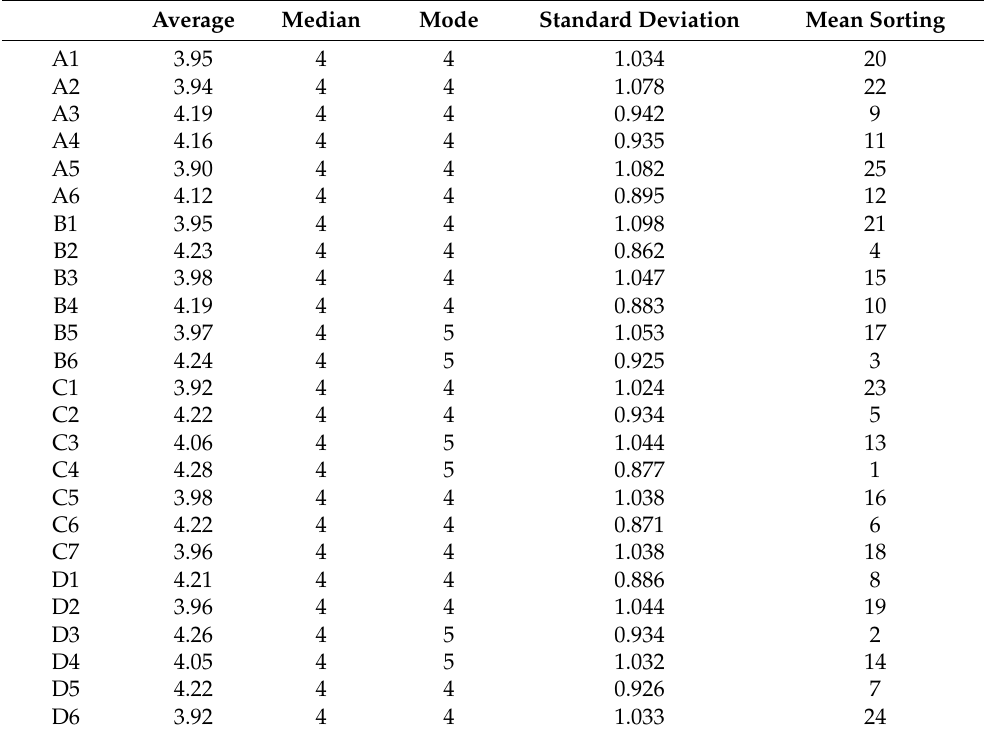
Table 4. BIM applications’ hindering factors impact assessment